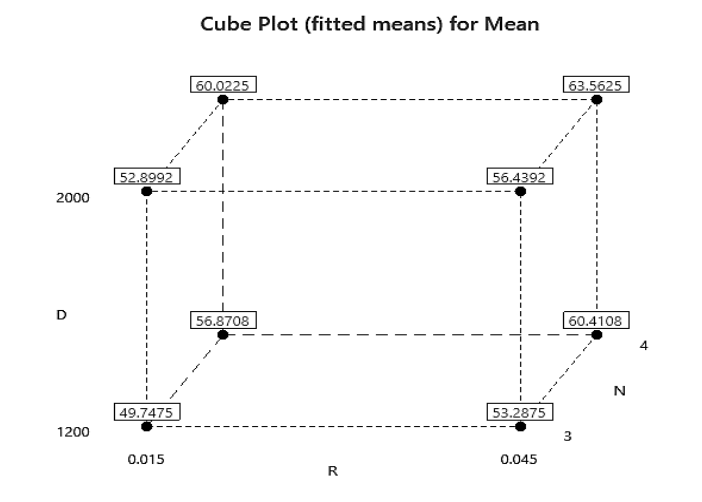
Fig. 5. Fitted means Cube plot for mean values vs R [17], D, and